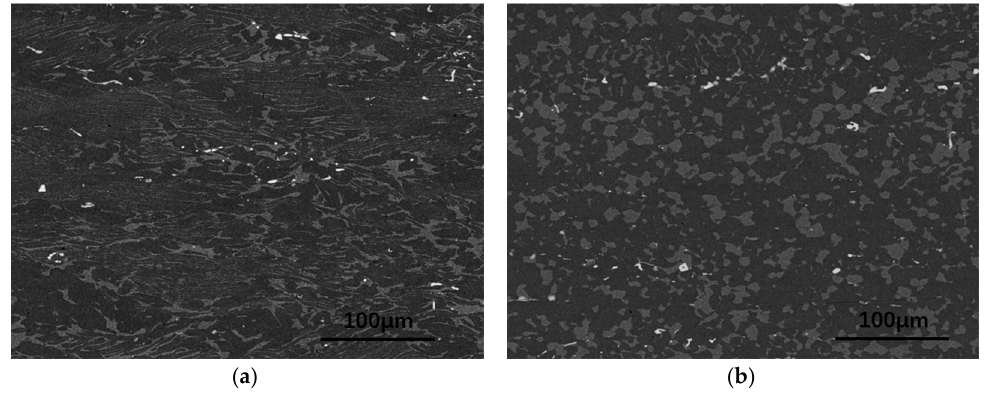
Figure 6. Microstructures of specimens isothermally deformed at the temperature of 1200 °C and different strain rates of ( a ) 1 s − 1 ; ( b ) 0.001 s − 1 .